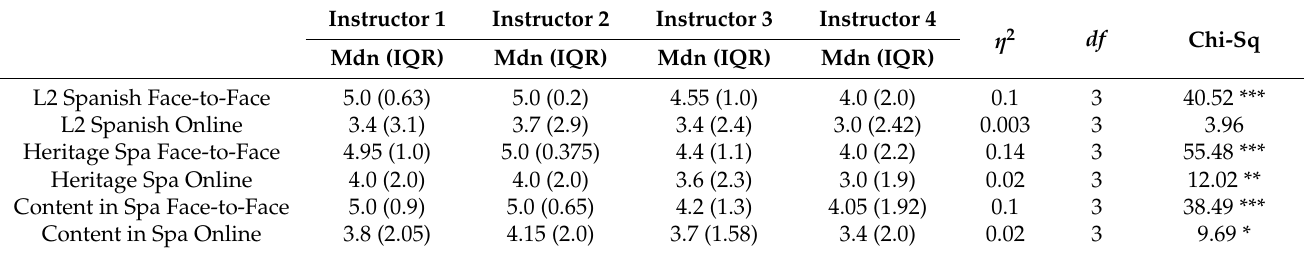
Table 3. Kruskal–Wallis Non-parametric tests for instructor preference for each class type